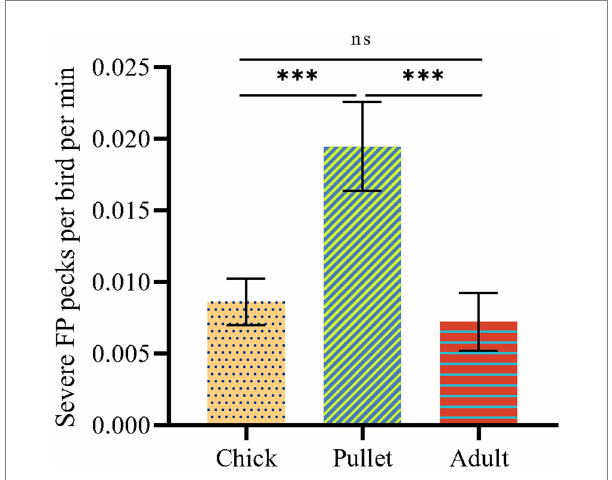
FIGURE 1 The SFP frequencies of birds at different stage of laying hens. The statistically significant differences between different groups are indicated as asterisks ( * p < 0.05, ** p < 0.01, and *** p <